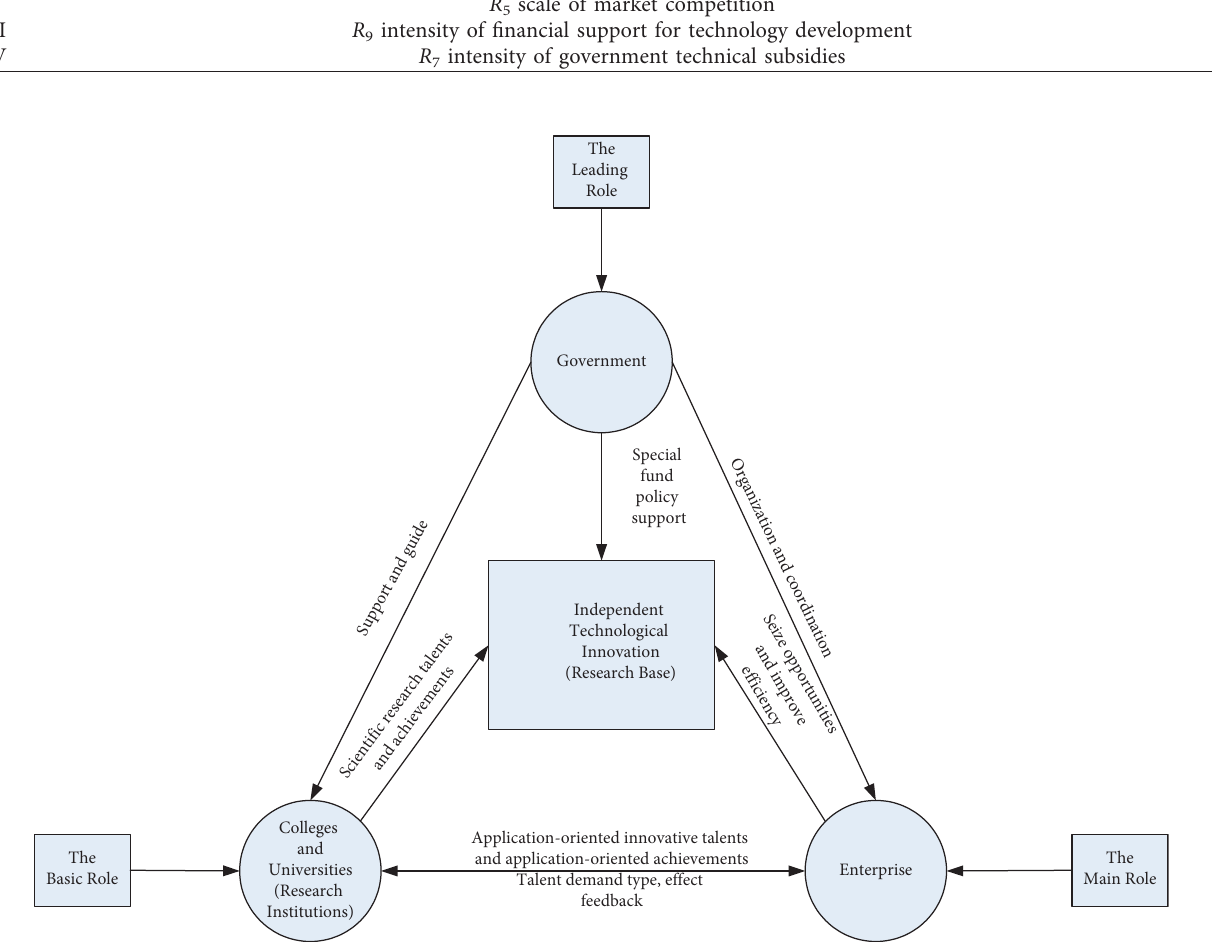
Figure 3: Strategy model of technology independent innovation of equipment manufacturing